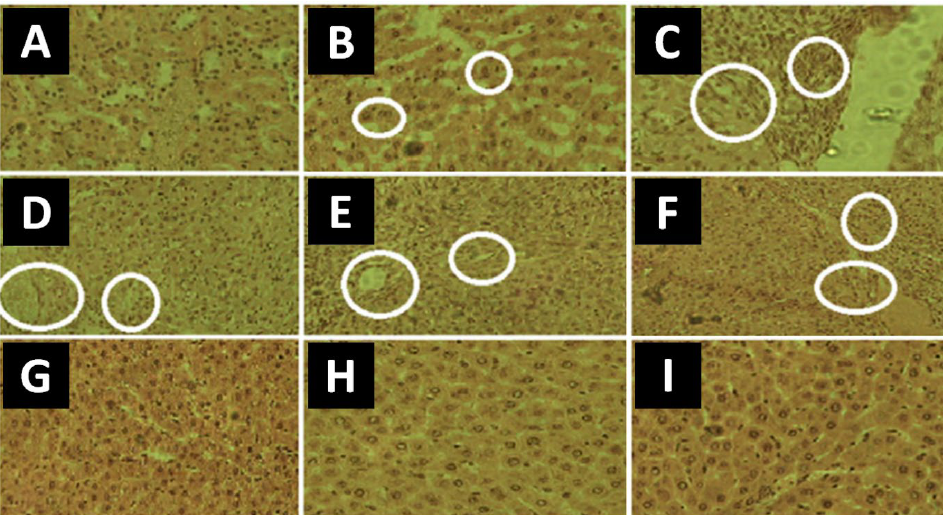
Figure 11. Histological sections of livers from untreated rats, from rats treated with free rifampicin (RFP) and from rats treated with RFP-loaded chitosan nanoparticles (NPs) (magnification: × 400). ( A ) Untreated group. ( B – G ) Group treated with free RFP (regions of interest circled in white). ( B ) Hydropic degeneration. ( C ) Lobular hepatitis. ( D ) Apoptosis. ( E ) Vein congestion. ( F ) Portal tract expansion. ( G ) Group treated with free RFP. ( H ) Group treated with empty chitosan NPs. ( I ) Group treated with RFP-loaded chitosan NPs. Adapted from reference [114], used under Creative Commons BY 4.0 license.